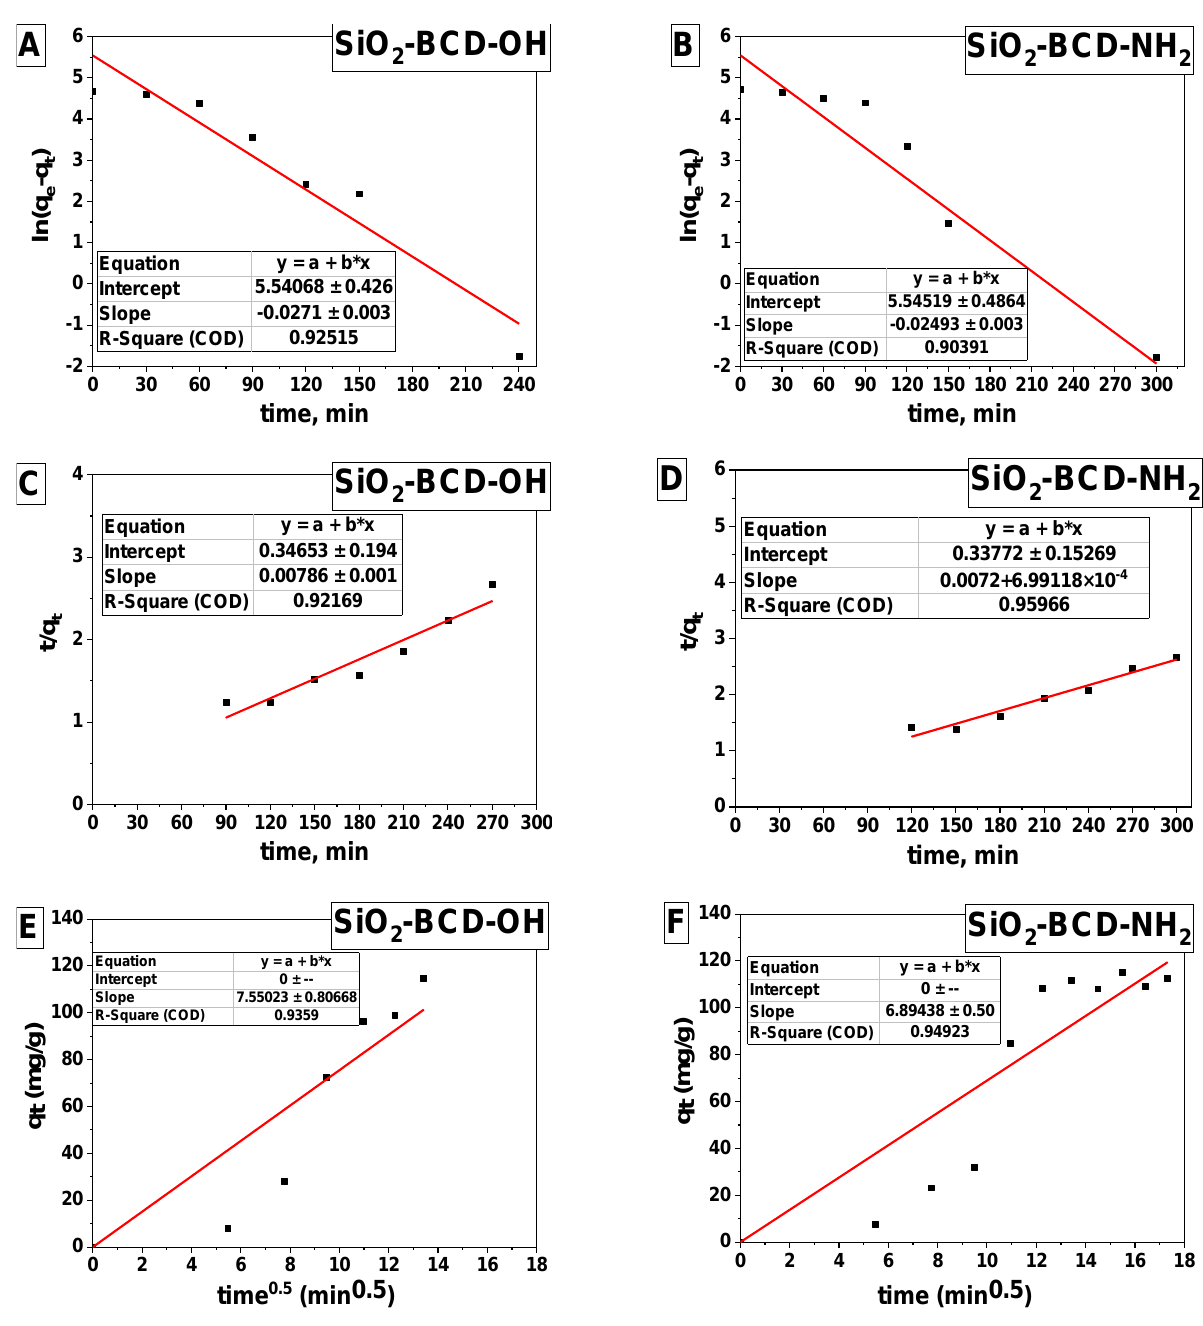
Figure 5. The linear plots of Lagergren’s pseudo-first-order ( A , B ), Ho’s pseudo-second-order ( C , D ), and Weber’s intraparticle diffusion models ( E , F ).